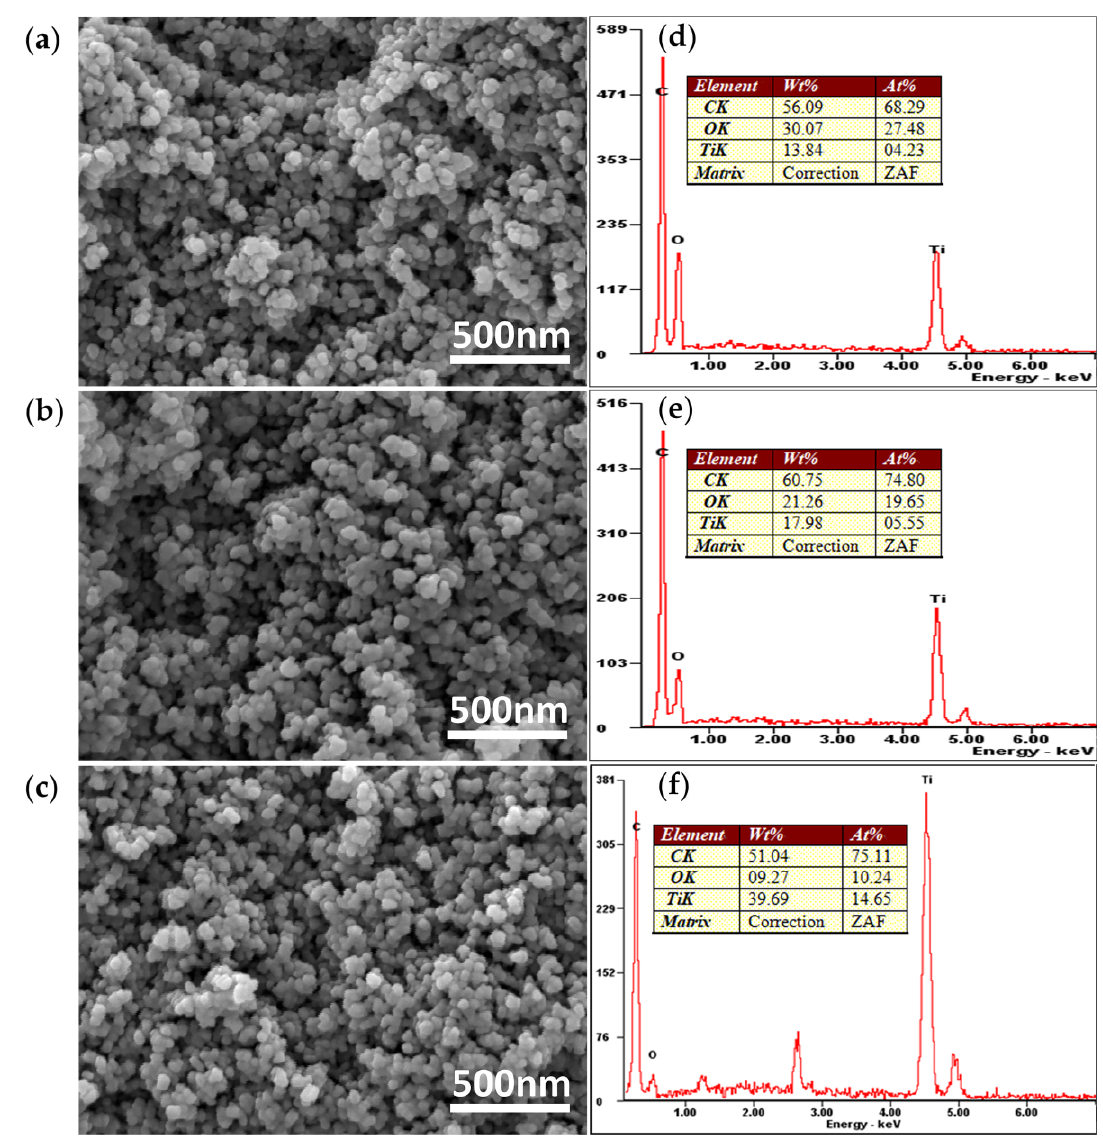
Figure 5. SEM images of ( a ) RF / TiO 2 aerogel, ( b ) C / TiO 2 aerogel and ( c ) TiC / C aerogel; the EDX spectra of samples ( d – f ) corresponding to ( a – c